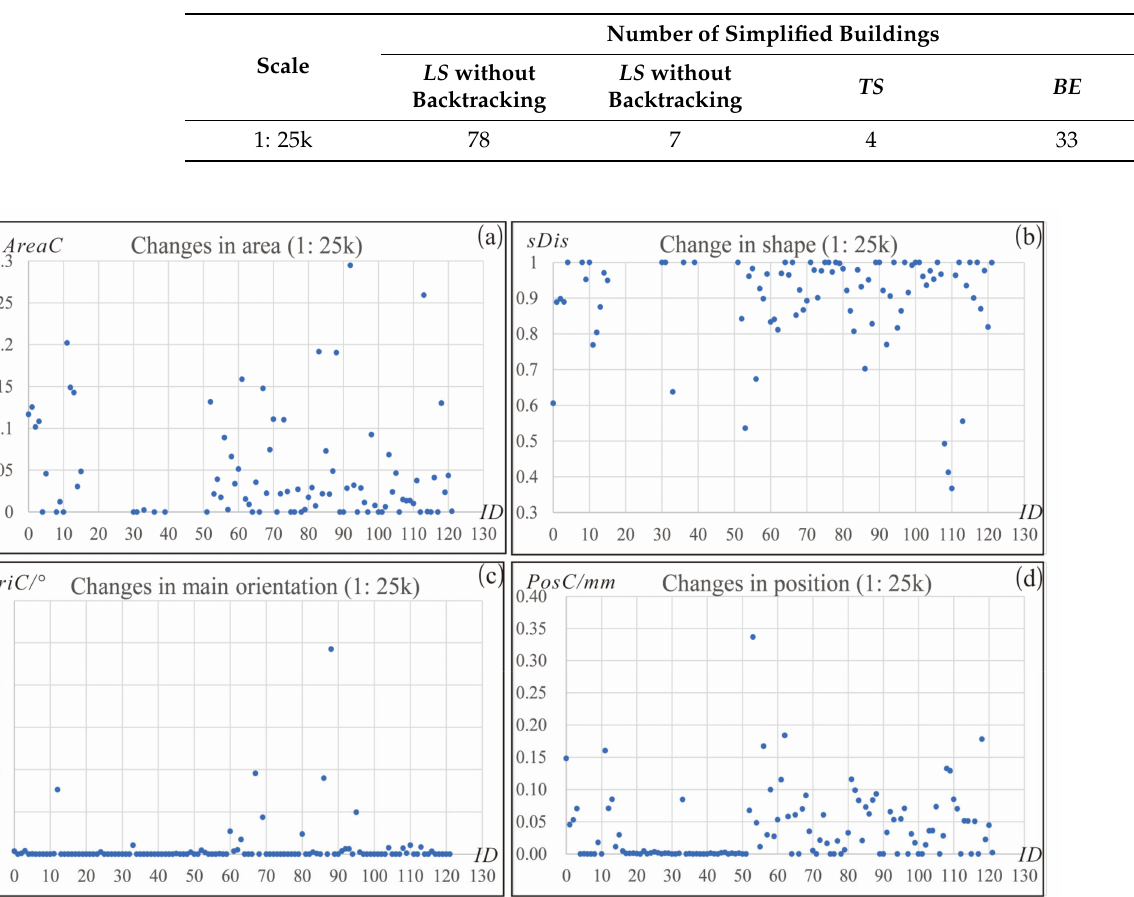
Table 3. Number of buildings simplified based on different algorithms.